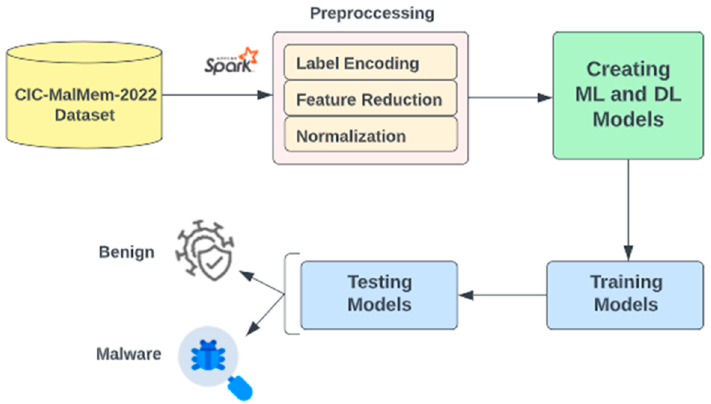
Figure 8. Malware Detection Flowchart.